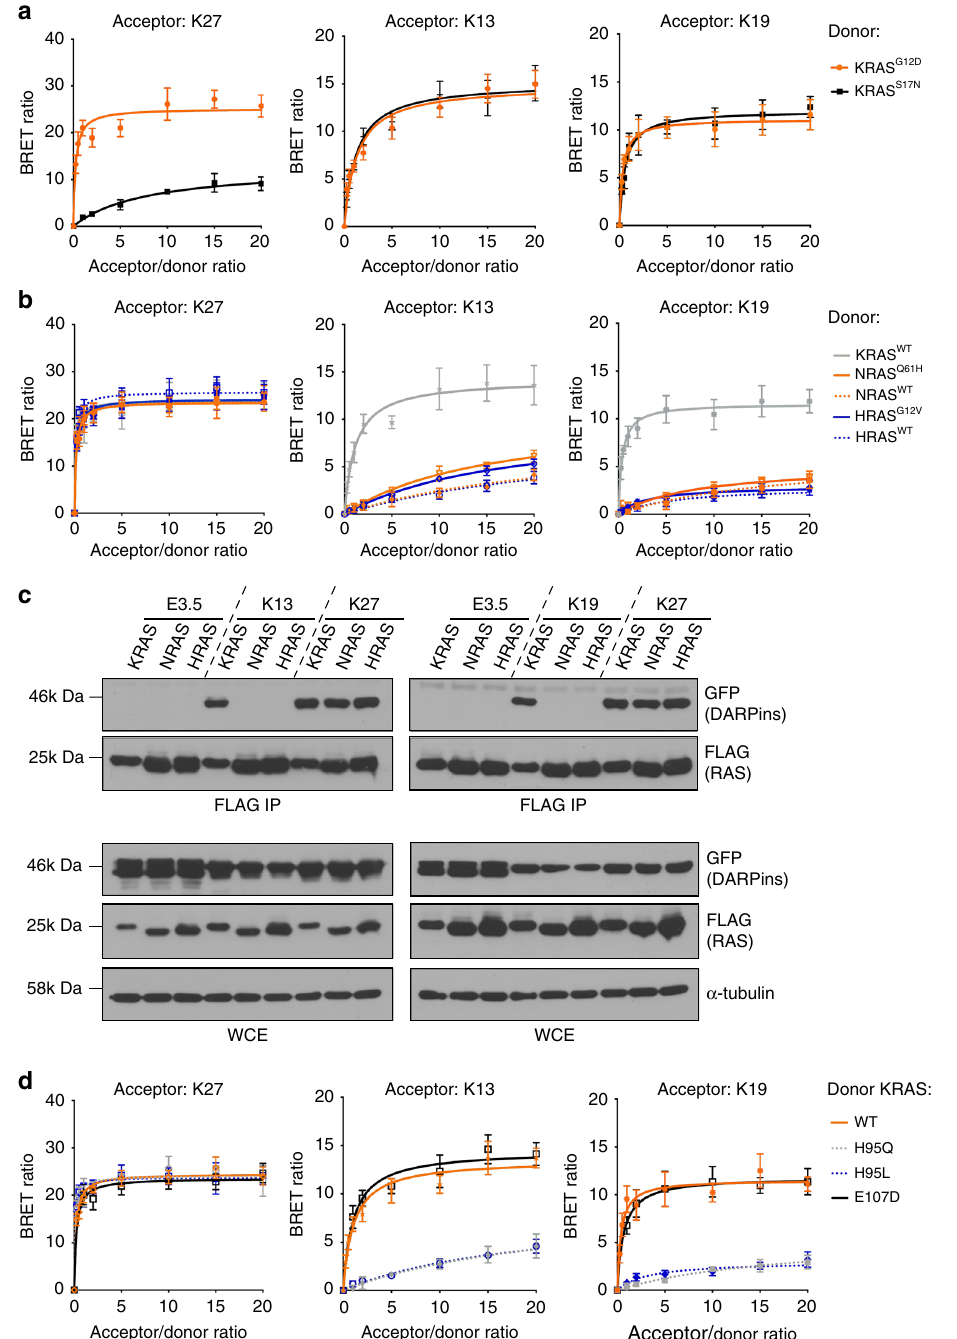
Fig. 3 K13 and K19 are KRAS selective binders. a BRET donor saturation assay between KRAS G12D or KRAS S17N (donors) and the DARPins (acceptors). b BRET donor saturation assay between KRAS WT , NRAS WT , NRAS Q61H , HRAS WT or HRAS G12V (donors) and the DARPins (acceptors). c Co- immunoprecipitation of 3xFLAG-KRAS WT , − NRAS WT and − HRAS WT with the DARPin-GFP 2 fusions in 10% foetal bovine serum. IP Immunoprecipitation, WCE whole-cell extract. d BRET donor saturation assay between KRAS WT , KRAS H95Q , KRAS H95L or KRAS E107D (donors) and the DARPins (acceptors). Note that most of the donor saturation curves with K27 as acceptor are overlapping in panels b and d . Each experiment was performed three times ( a – d ). Error bars are mean ± SD of biological repeats. c Source data are provided as a Source Data fi